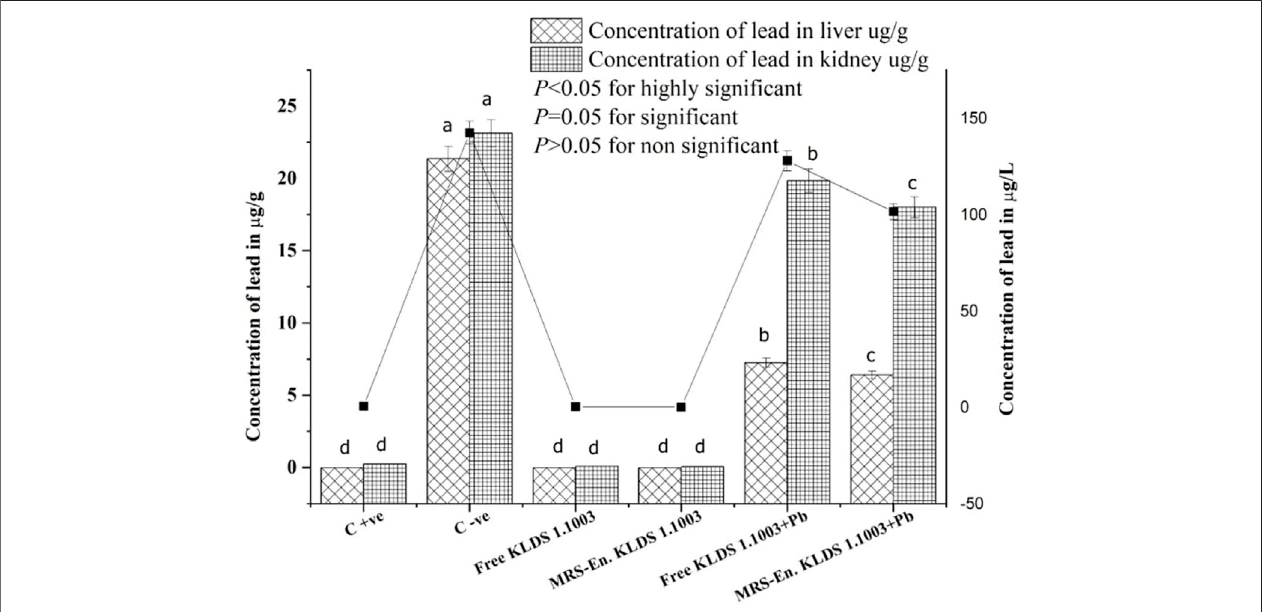
FIGURE6| In fl uenceoffeedingfreeand MRS-based encapsulated L. acidophilus 1.1003on thelevels ofPb inthe blood (µg/L) ofmice presented withasolid line, inthekidney(µg/g)andliver(µg/g)ofmicepresentedwithbarwithleadnitrateindrinkingwater.Thesigni fi cantdifference( p < 0.05)isshownbyletters.Valuesaremean ± standard deviation (SD).